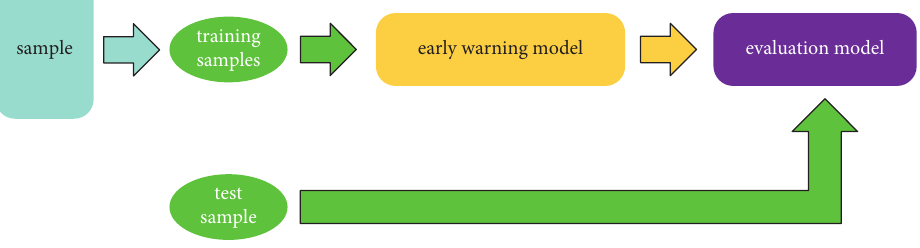
Figure 4: Early warning model research process.